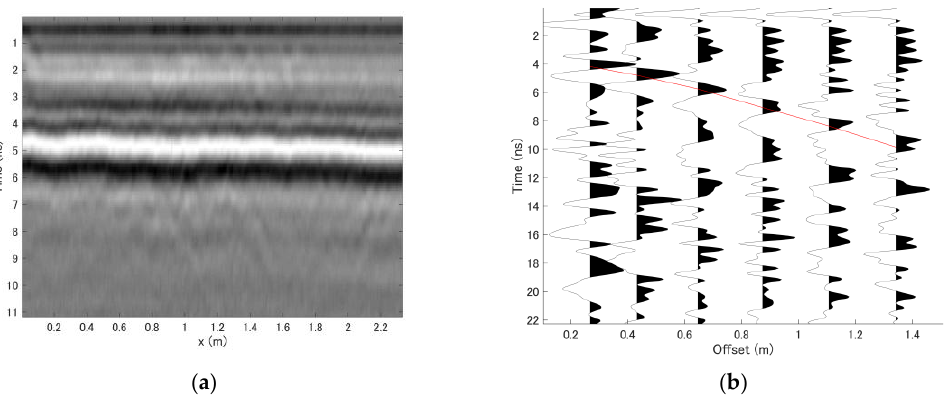
Figure 12. Datasets acquired with Yakumo. ( a ) Vertical profile at y = 0.72 m. ( b ) CMP dataset acquired at x = 2 m and y = 1 m. The solid line indicates the reference thickness and velocity of the reflection layer.